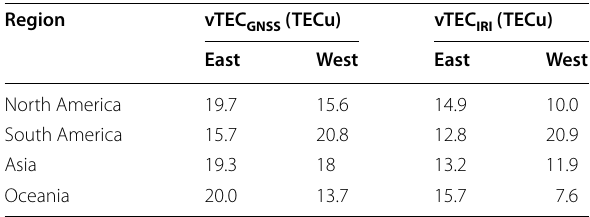
and vTEC GNSS IRI